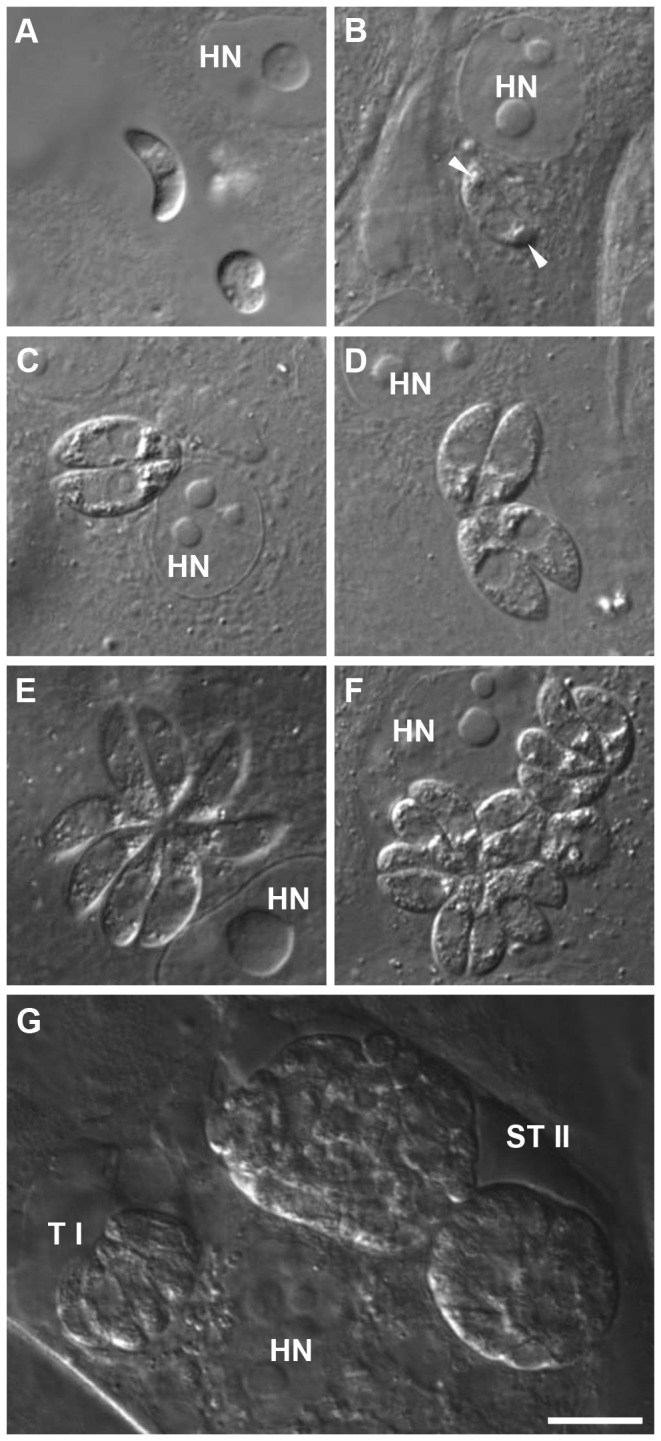
Sporozoites and merozoites of

I

. suis

in vitro in intestinal porcine epithelial cells (IPEC-J2).(A) extracellular sporozoite before cell invasion on dpi 0; (B) intracellular sporozoite 24h after infection, note the anterior and posterior refractile body (arrow heads); (C), (D), and (E) type I merozoites on dpi 5; (F) smaller presumptive type II merozoites on dpi 7; (G) two large groups of subtype II merozoites (ST II) and a small group of type I merozoites (TI) on dpi 9. HN, host cell nucleus; dpi, days post infection; bar = 10 µm.